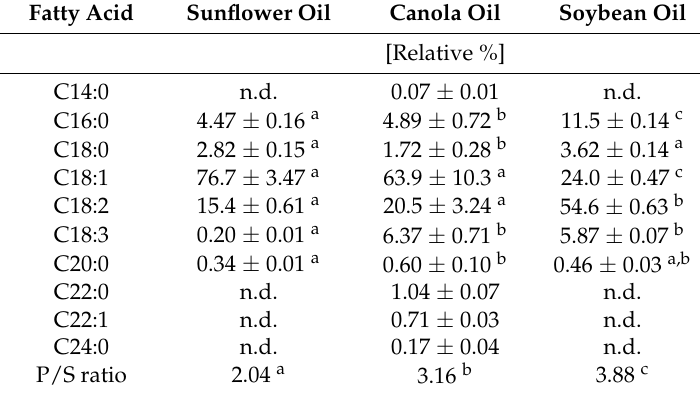
Table 2. Fatty acid profile of the tested vegetable oils d . Fatty Acid Sunflower Oil Canola Oil Soybean Oil